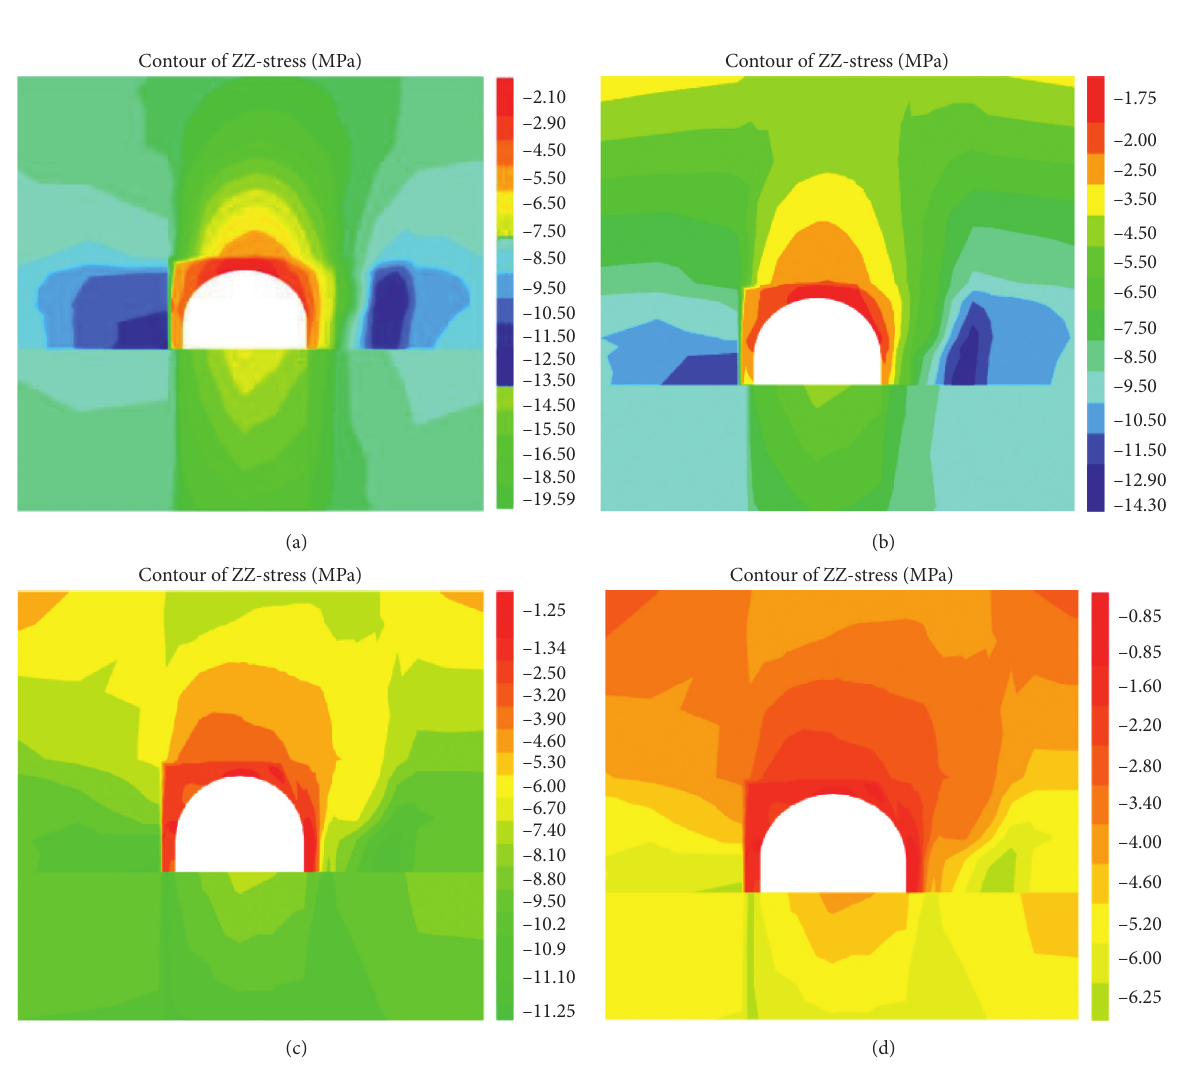
Figure 11: Stress change diagram of the surrounding rock before reinforcement: (a) working face advancing 12m, (b) working face advancing 36 m, (c) working face advancing 60 m, and (d) working face advancing